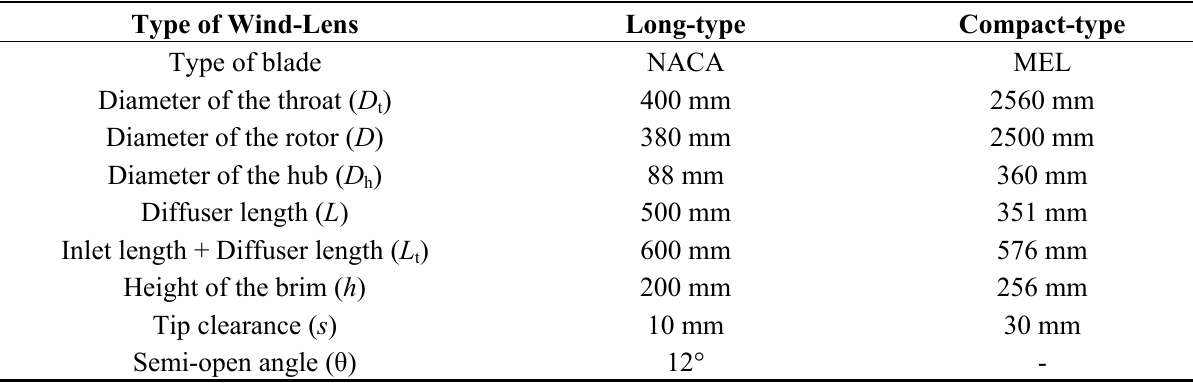
Table 2. Parameters for the configurations of the Wind-Lens